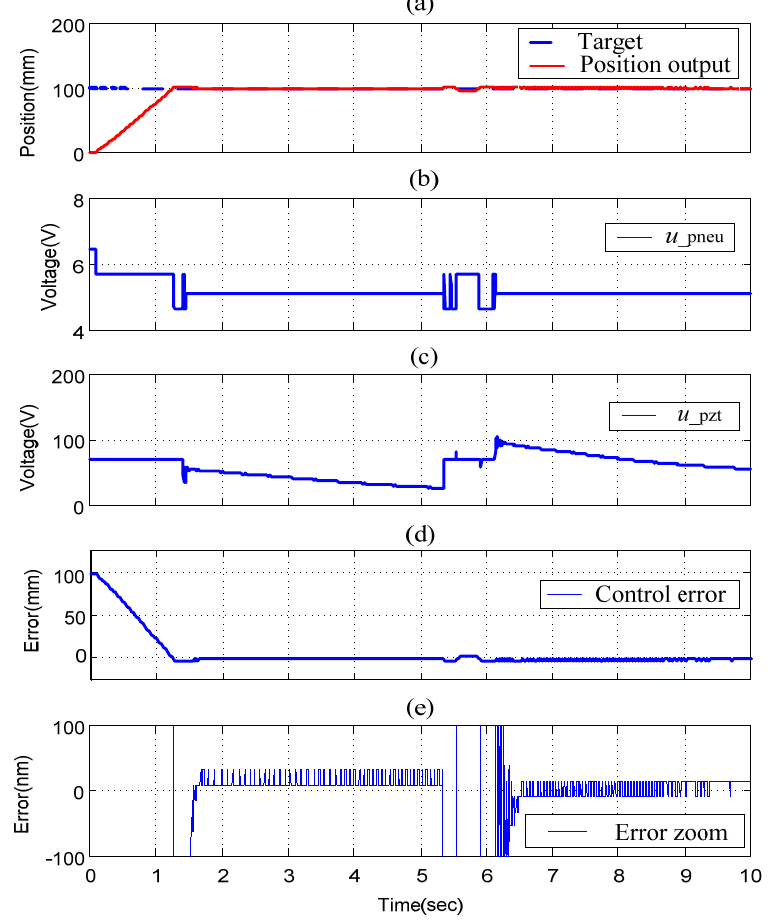
Figure 11. Robustness test of the position control of pneumatic-piezoelectric hybrid actuator for single axis by DSOFSMC: (a) position control response, (b) pneumatic control signal, (c) piezoelectric control signal, (d) position control error, (e) error